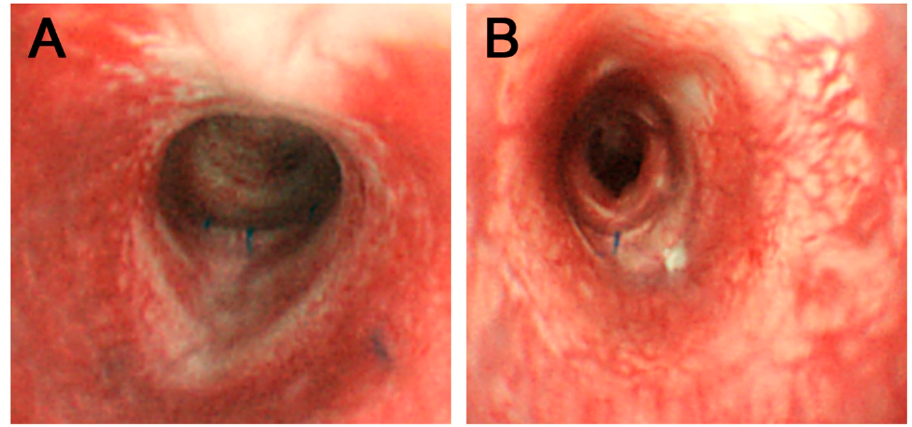
Figure 5. Bronchoscopic findings. Bronchoscopic images of MSC group ( A ) and d-MSC group ( B ) were obtained 12 weeks after the surgery. Tracheal lumen fully covered with epithelial mucosa was observed. Remaining suture materials indicate the implant fixation site.